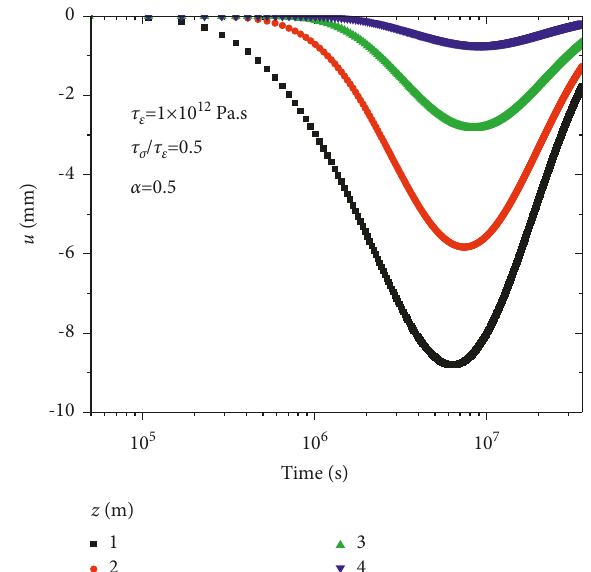
Figure 14: Influence of embedment depth on displacement when τ